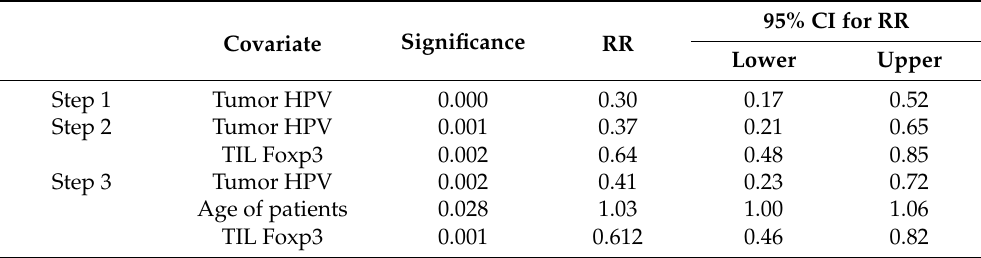
Table 6. Cox stepwise regression five-year disease-specific survival analysis including age at diagno- sis, T stage, epithelial levels of Foxp3-positive cells, HPV status and whether tumor p16